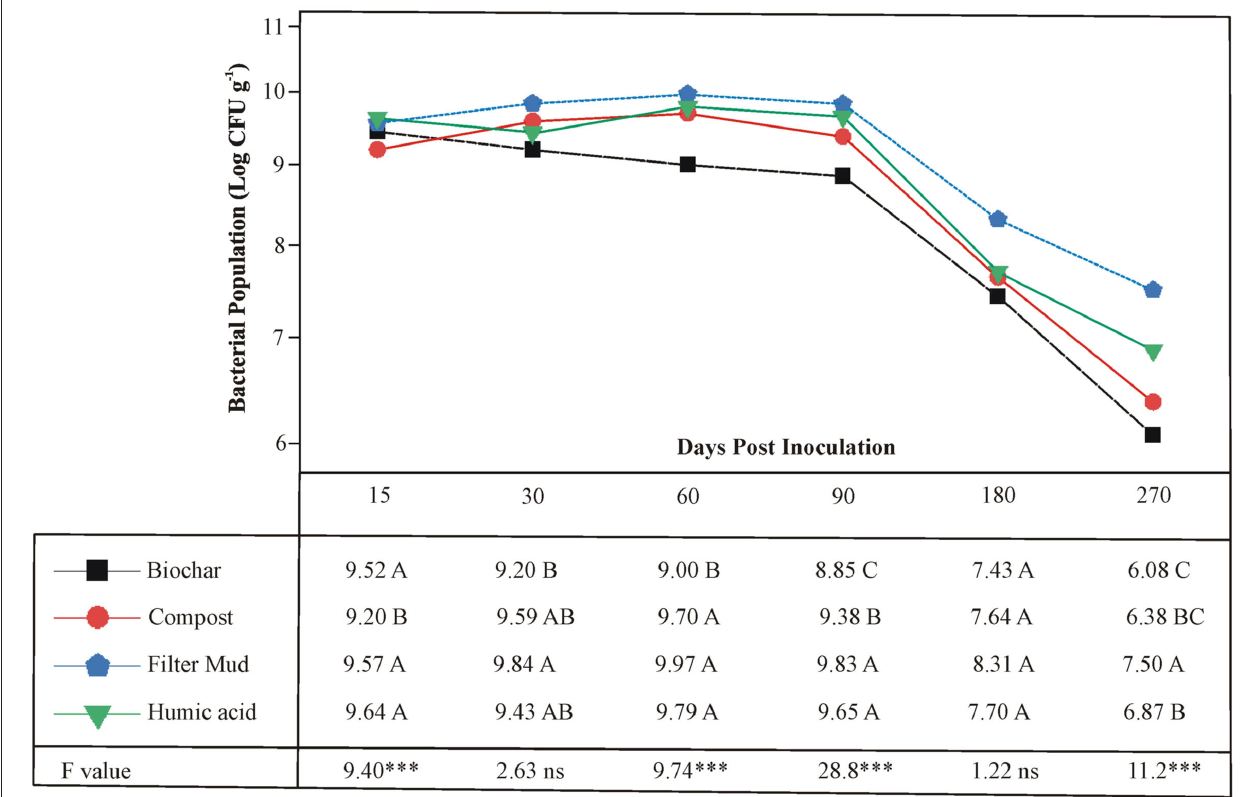
FIGURE 3 | The shelf life of bioformulations to assess the survival of inoculated PSB in different carrier materials. Each point represents decimal logarithmic of viable cells g − 1 carrier material and it is the mean value of three replicas. The ANOVA has been performed within each sampling date, thus within each column in data table, and the F and significance values (*** p ≤ 0.001, ns not significant) are provided; the values followed by the same letter, within each column, are not significantly different at p < 0.05 in the LSD